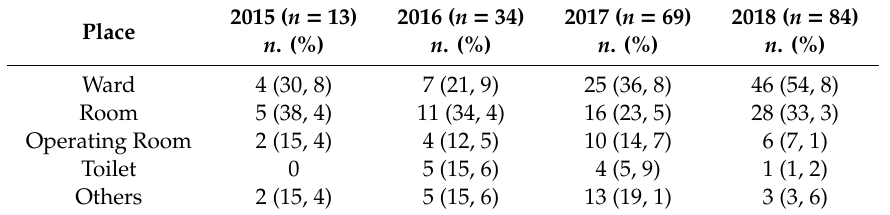
Table 4. Distribution (%) of Incident Reporting records, by place of event and the reporting year.